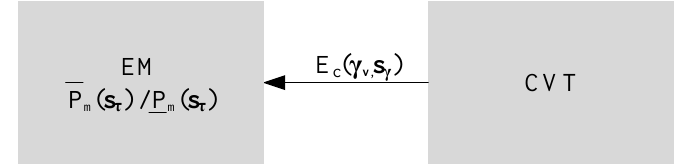
Figure 10. Convex modeling of the EM power limits.